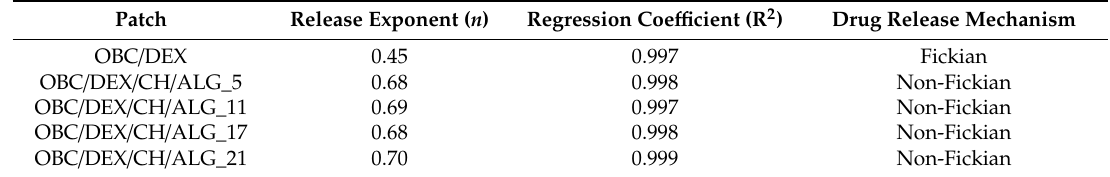
Table 3. Fitting parameters of the Korsmeyer–Peppas kinetic model and the corresponding drug release